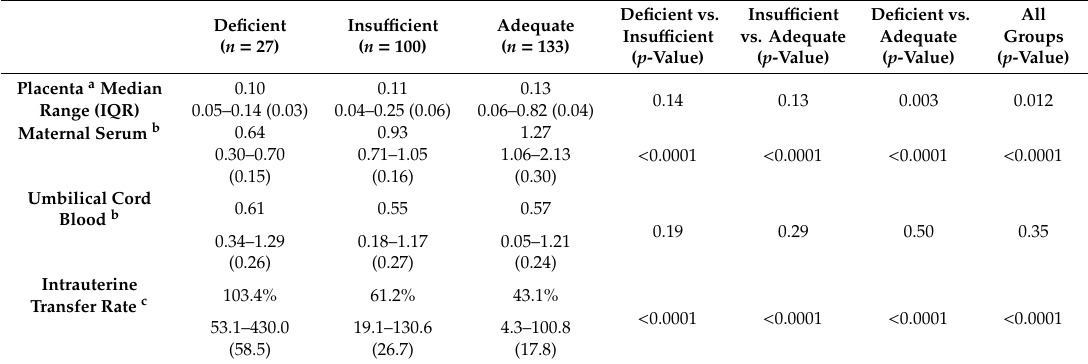
Table 5. Comparison of retinol concentrations and intrauterine transfer rate between maternal retinol